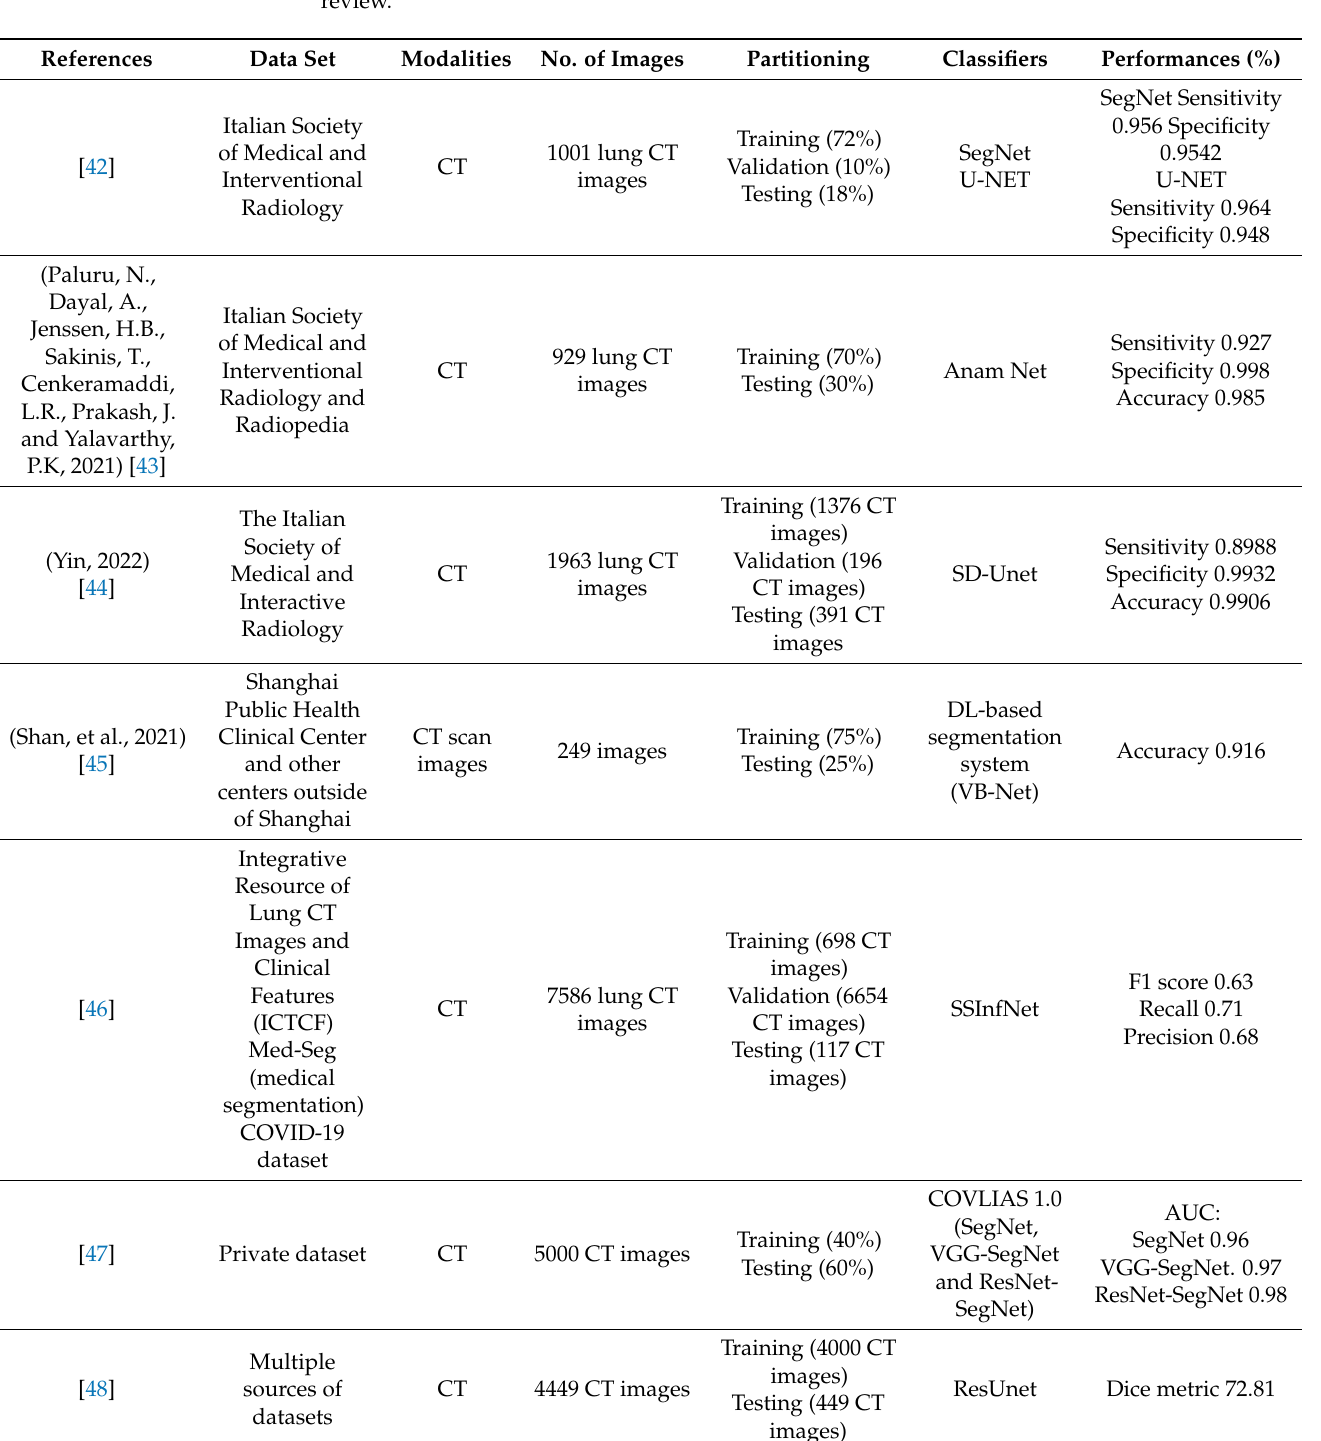
Table 4. Summary of deep learning segmentation methods used in the relevant publications in this